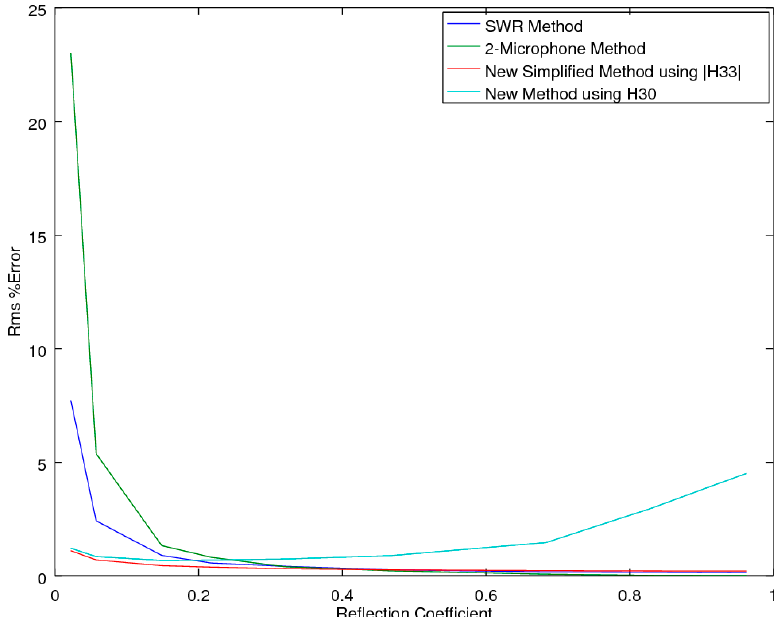
Figure 5. Comparison of accuracy from the computation of R, with a normalized noise level of 0.005 and a β value of 0.1. Comparison is between the two standard methods, SWR [2] and the two-microphone method [5,6], and the technique utilized in the three-microphone method [14], versus the new proposed methods utilizing the simplified |H 33 | method (amplitude only measurements) and the technique that uses a measurement of H 30 (complex measurements that include phase relationships).